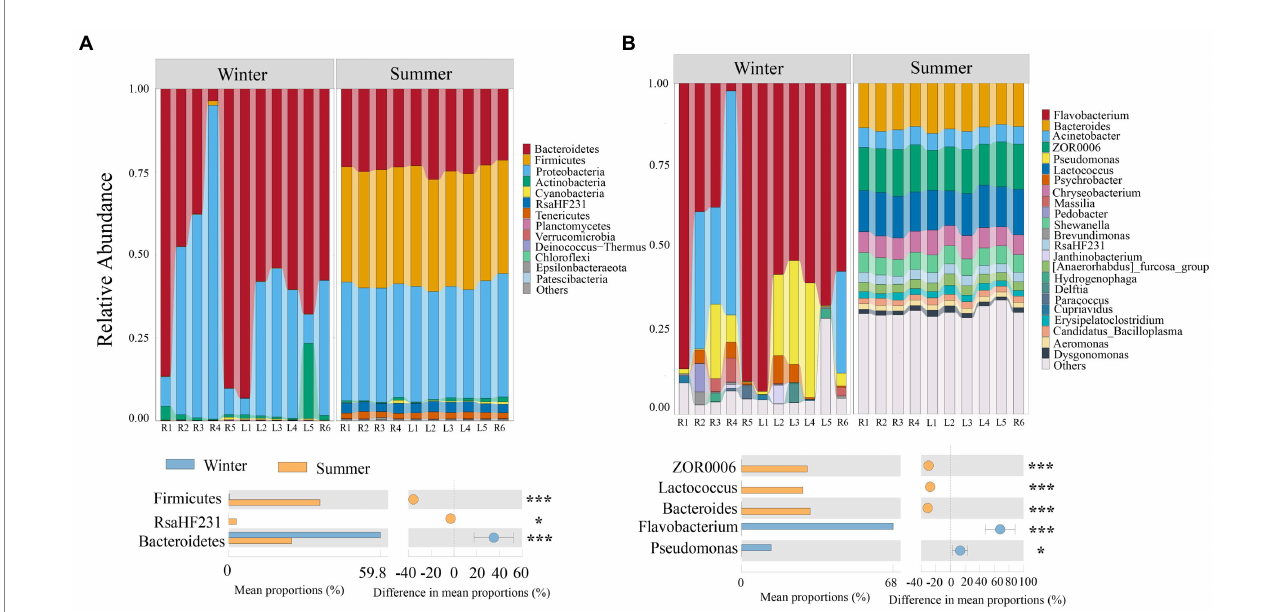
FIGURE 3 Temporal and spatial distribution of bacterial community in subsidence lake and natural river. (A) Distribution of bacterial communities composition at different levels. (B) Significantly different bacterial community compositions between different seasons. Two comparisons with Wilcoxon tests, * p < 0.05, ** p < 0.01, *** p <